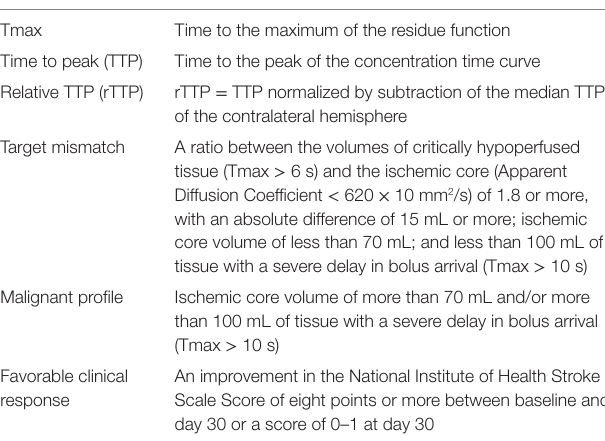
TaBle 1 | Definitions used in the